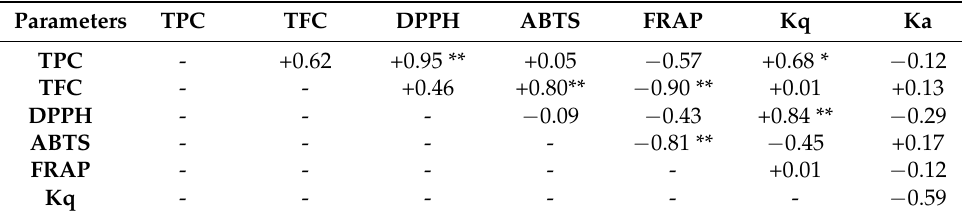
Table 6. Pearson’s correlation coefficients (r) 1 between the